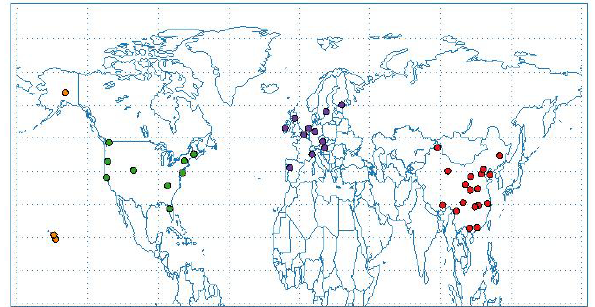
Fig. 8. Observational sites from CAWNET (red circles), EMEP (purple circles) and IMPROVE (green circles). Remote sites HAVO, HALE and DENALI are from IMPROVE with orange circles.